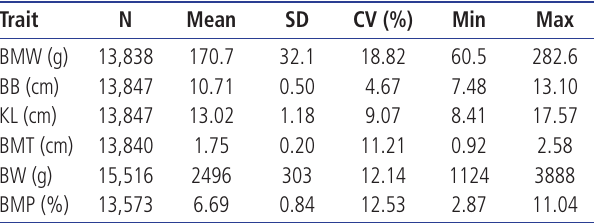
Table 1. Statistical summary of performance of breast meat related